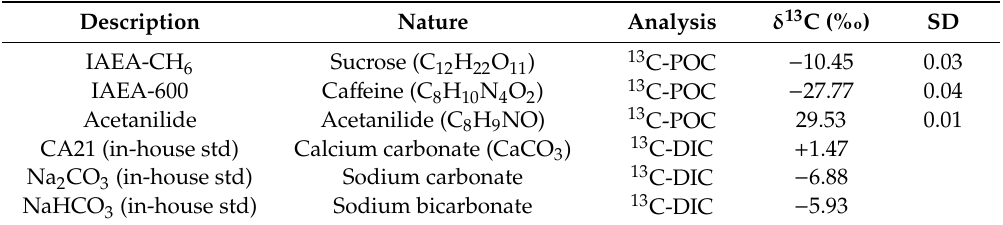
Table 1. List of international and in-house standards used for EA-IRMS and GB-IRMS analysis. IAEA: International Atomic Energy